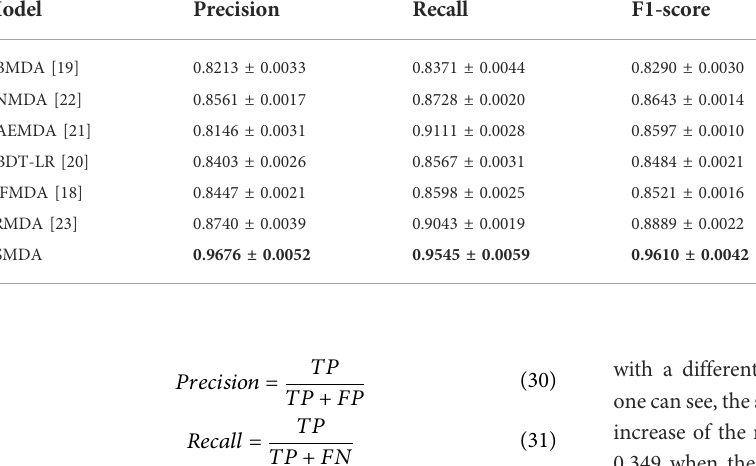
TABLE 3 Performance comparison of the CSMDA with other MDA prediction models.